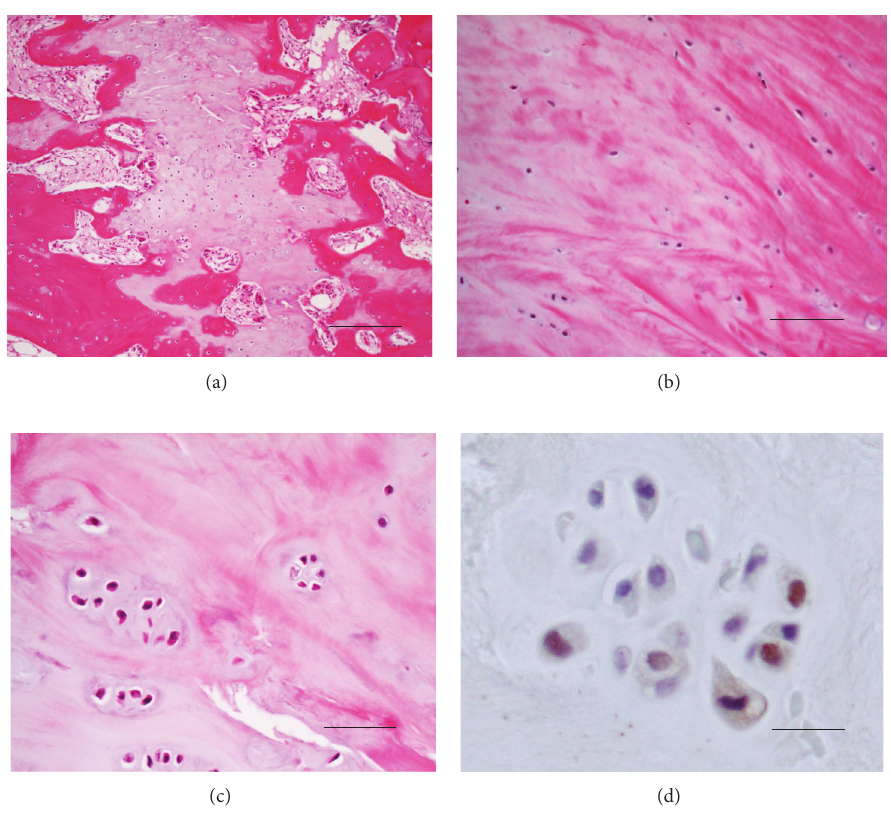
Figure 2: (a) Growth plate remnant with a sclerotic margin. Moderate reduction in hematoxylin-eosin staining and disorientation of chondron columns in the olecranon physis. (b) Magnified view showing a decreased number of chondrocytes in the lesion. (c) Chondrocyte cluster formation in the lesion. (d) Proliferating cell nuclear antigen-positive cells in a chondrocyte cluster. Bars: 200 𝜇 m (a), 100 𝜇 m (b), 50 𝜇 m (c), and 20 𝜇 m